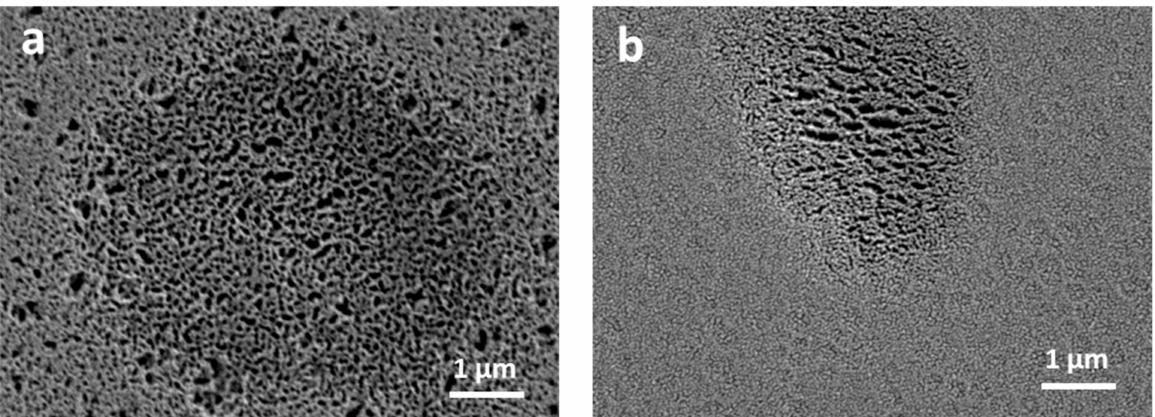
Figure 3. SEM image of PEAI; ( a ) and PEAI-F; ( b ) single crystal after laser